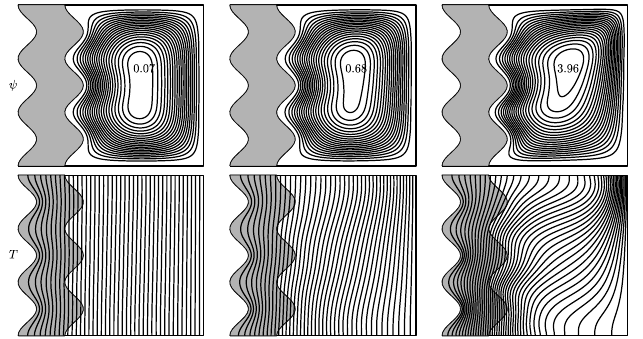
Figure 5. Variation in Ra when Ha = 25, kr = 1, γ = 0 ◦ , A = 0.05, n = 3. Streamlines and isotherms at the ( top ) is for case 1, at the ( middle ) is for case 2 and the at ( bottom ) is for case 3.